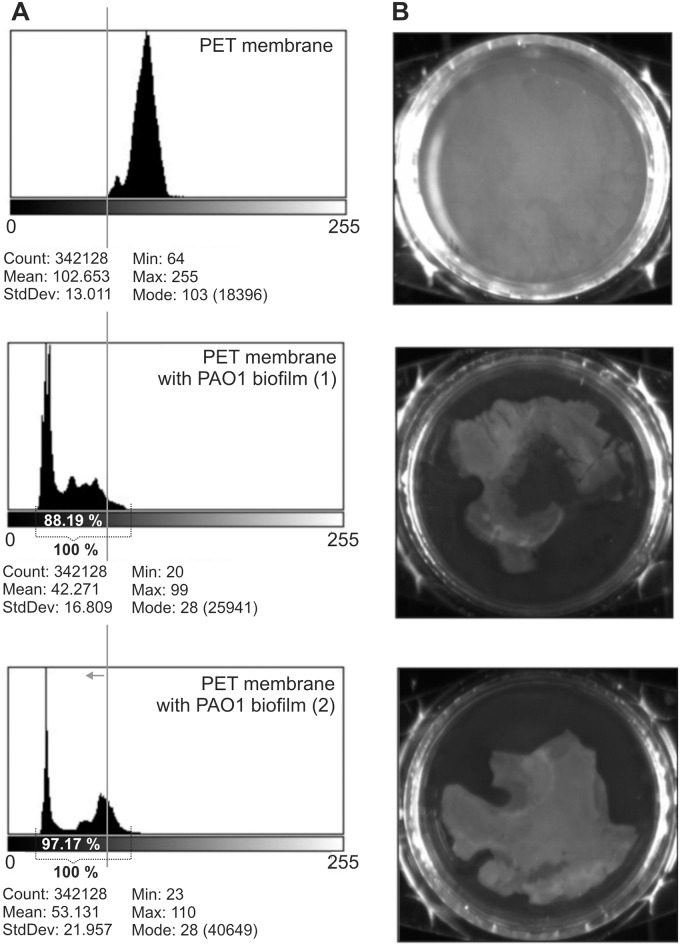
Histograms of imageJ software analysis of PAO1 biofilm (stained by CV) formed on PET membrane.(A) In left panel grey line presents cut-off point in which pixels from total analyzed (membrane with biofilm) have the grey level lower than control (native membrane). The % of membrane covering by biofilm formed for 72 h is presented. (B) Right panel presents images of analyzed membranes with/without biofilm. Analysis were done in two independent experiments.